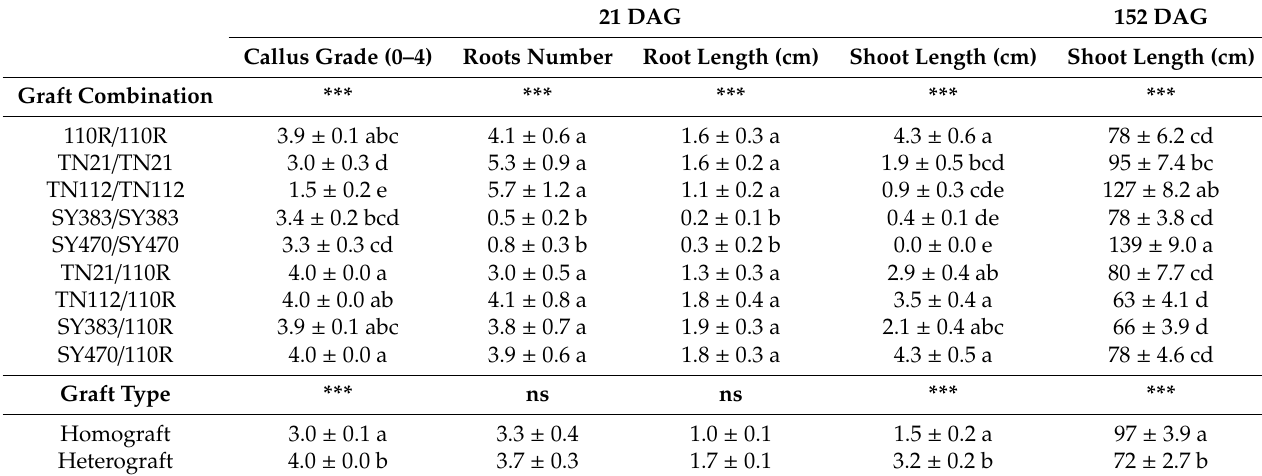
Table 1. Average of callus grade, root number, root length, and shoot length detected at 21 and 152